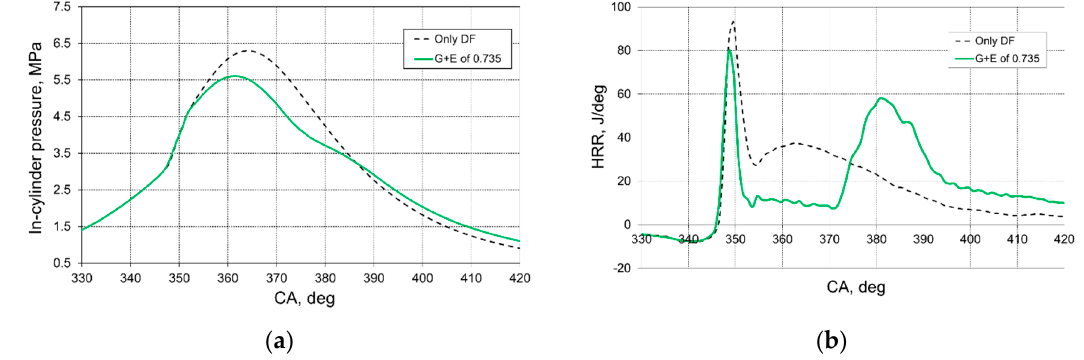
Figure 14. ( a ) In-cylinder pressure; ( b ) HRR vs. 𝐺 + 𝐸 fraction by energy content.